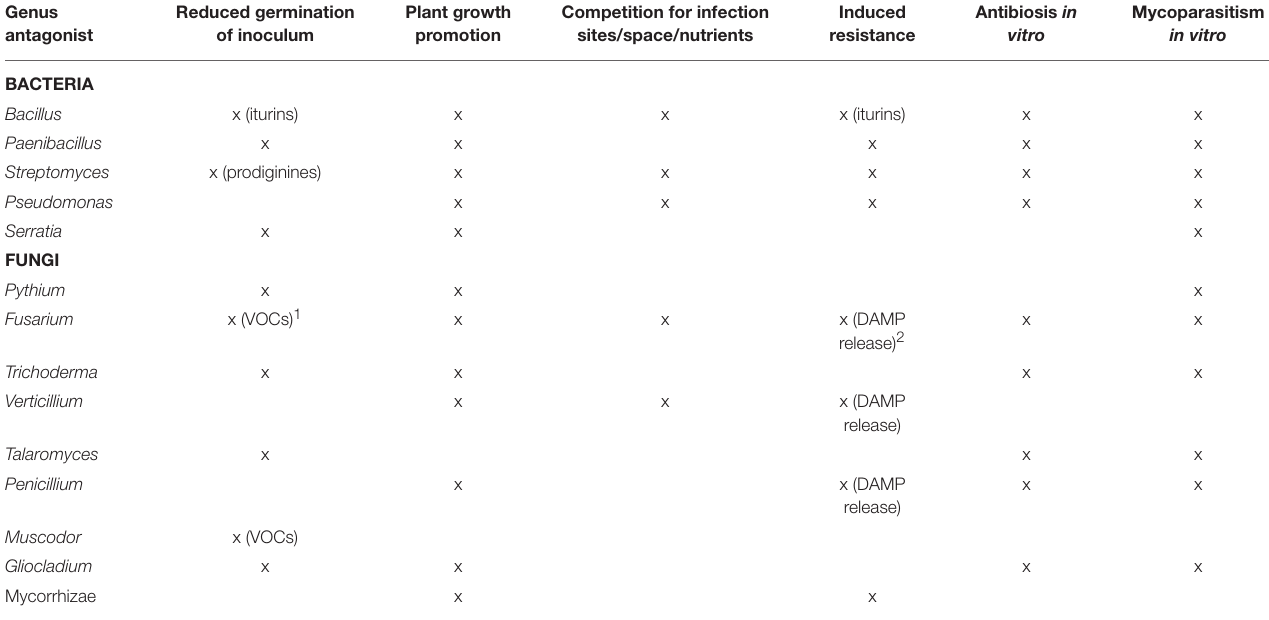
TABLE 4 | Mode of action of selected biocontrol agents against Verticillium wilt. Genus Reduced germination antagonist of inoculum